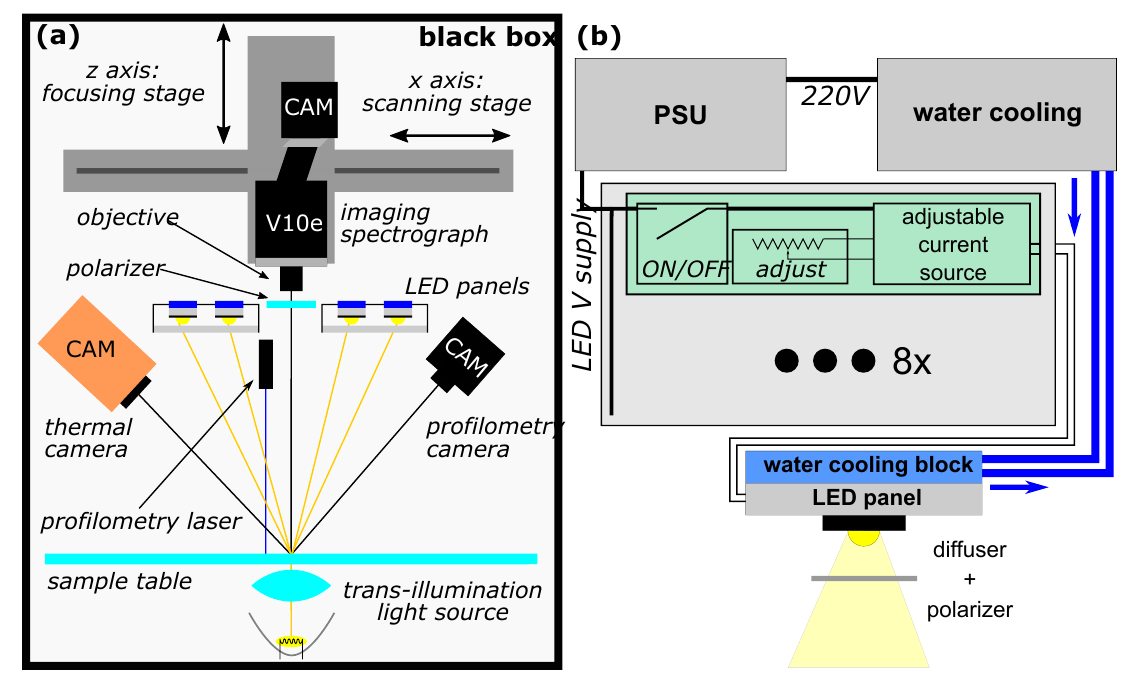
Figure A1. Outline of the custom-made laboratory hyperspectral imaging (HSI) system set-up. ( a ) Outline of the whole system. ( b ) Outline of LED panels with power supply electronics and